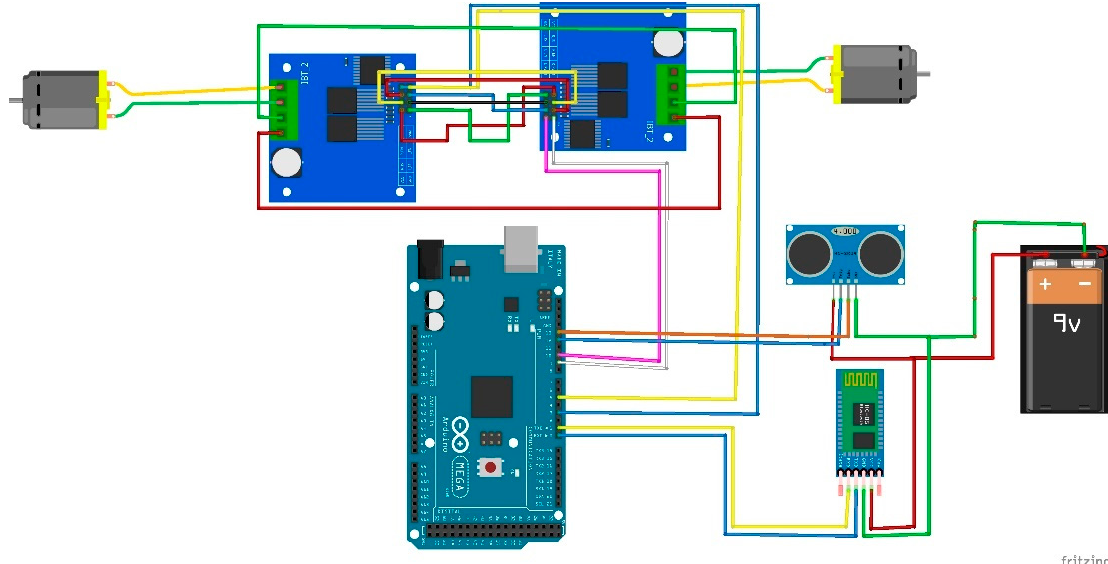
Figure 3. Obstacle avoidance and Bluetooth communication circuit.